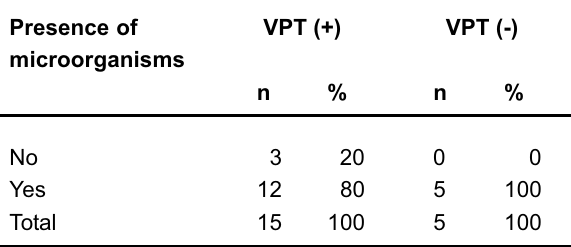
Sensitivity = 80%; Specificity = 0%; Accuracy = 60%; n: number of